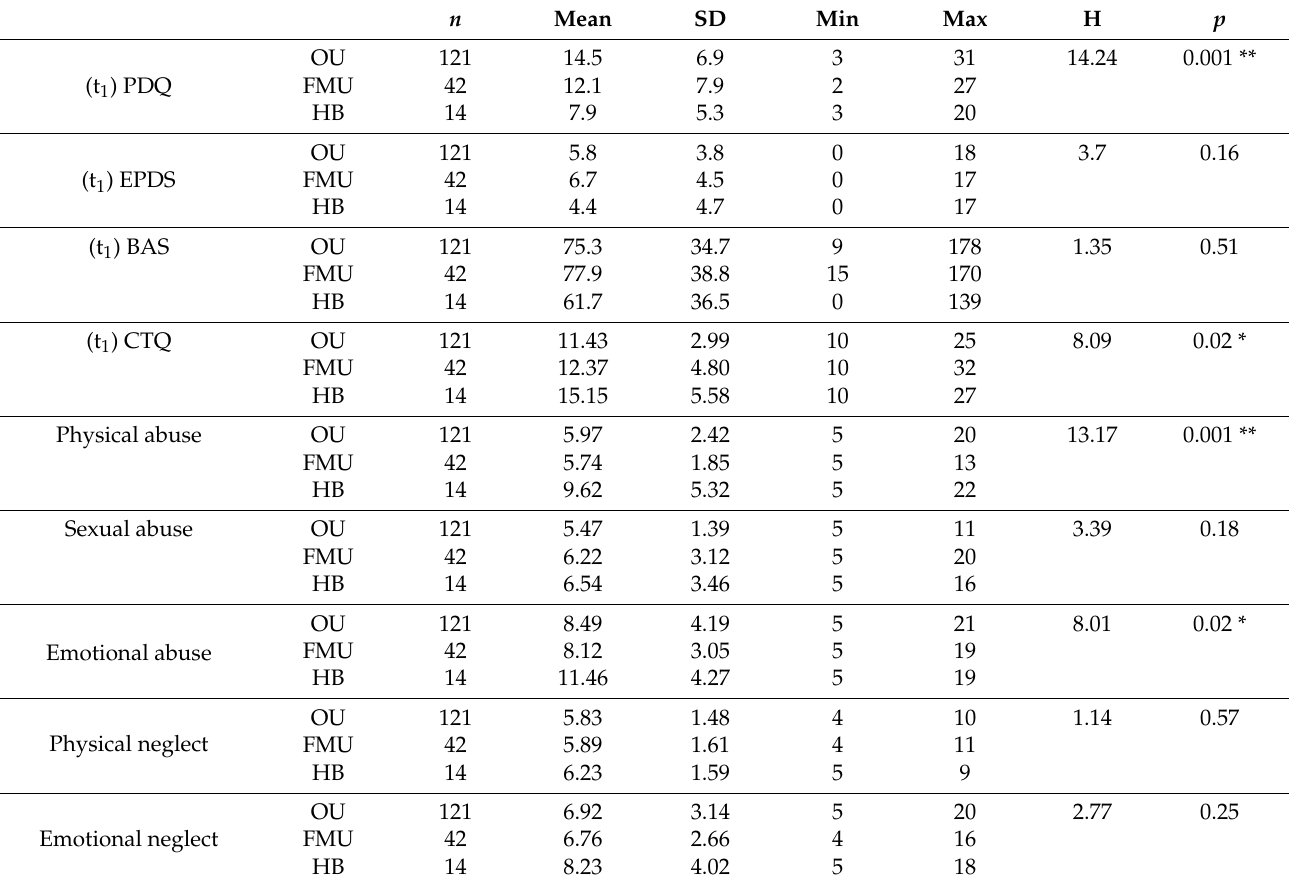
Table 2. Association between planned place of birth and prepartal scores of prenatal distress, depressive symptoms, birth anxiety symptoms and childhood trauma (t 1